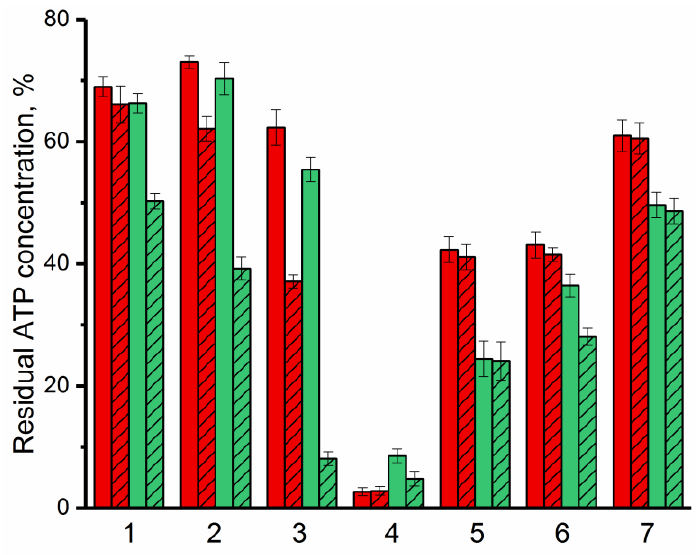
Figure 4. Residual ATP concentration in cells as a manifestation of antimicrobial activity of lactoferrin (red) and Lfcin (green) against G( − ) ( Pseudomonas putida (1), Pseudomonas sp. (2), Agrobacterium tumefaciens (3)) and G(+) ( Bacillus subtilis (4), Lactobacillus sp. (5)) bacteria, and yeasts ( Saccharomyces cerevisiae (6), Candida spp. (7)) in the absence (solid) or in the presence of His 6 -OPH (crosshatched). Concentration of cells in the medium without any additives was assessed as 100%.